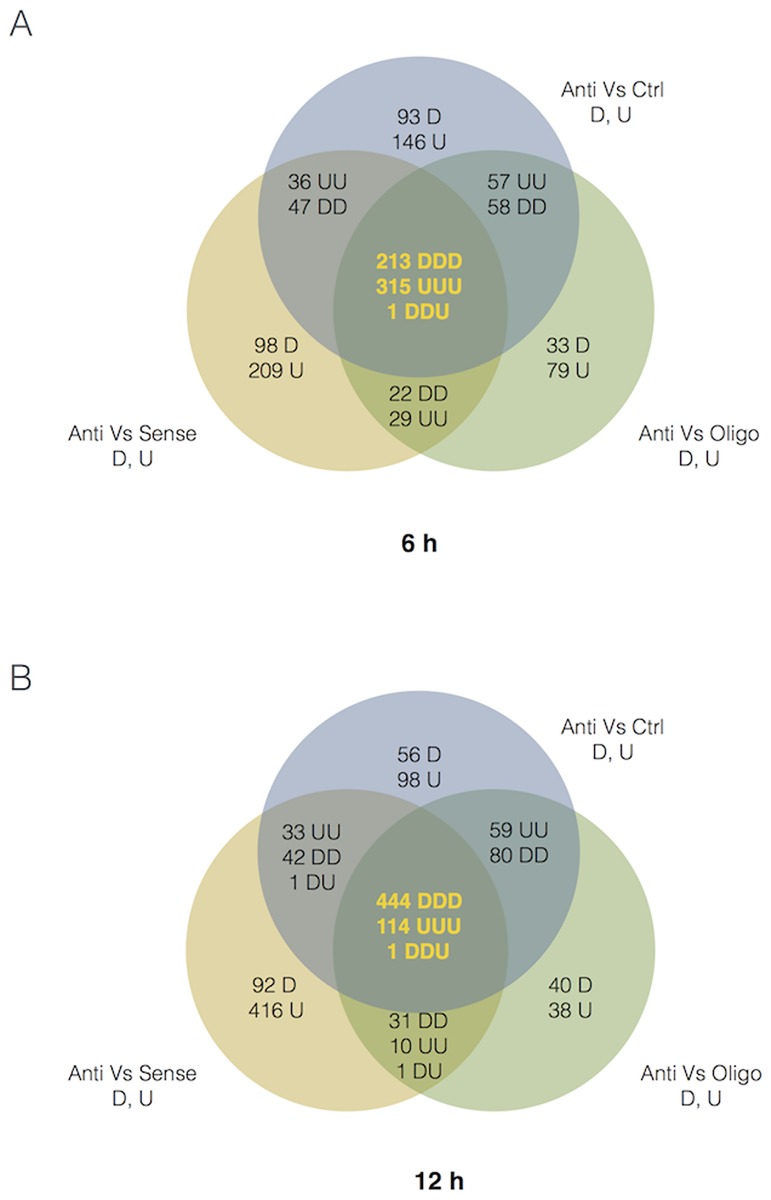
Venn diagrams showing pair-wise comparison between ASO and CTRL, ASO and OLF, finally ASO and SO at 6h and 12h.For intersections letters are in clockwise order of, for example DD for {Anti vs Ctrl} Intersect {Anti vs Oligo} means first D in {Anti vs Ctrl} and second D in {Anti vs Oligo}. Concerning the central intersection (yellow numbers) the clockwise order starts from Anti vs Ctrl. D means down-regulated and U up-regulated.